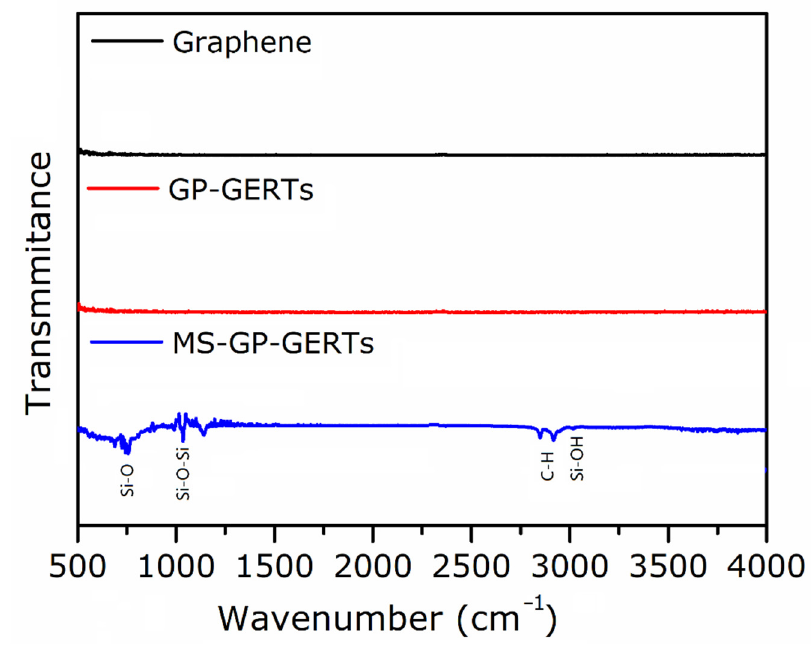
Figure 3. FTIR spectra of graphene, GP-GERTs, and MS-GP-GERTs.